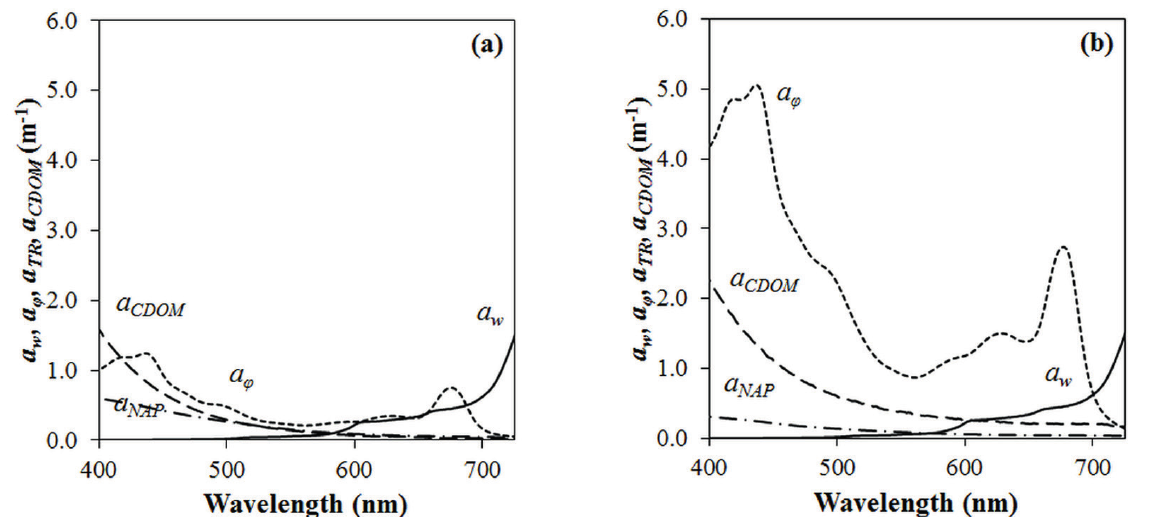
, solid line), phytoplankton ( a w , dotted-dashed line) measured in ( a ) May and ( b ) October NAP